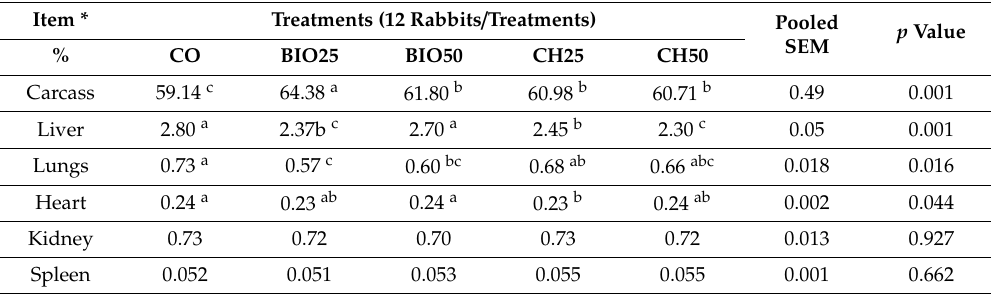
Table 4. Carcass traits of growing New Zealand (NZW) rabbits fed diets supplemented with biological or chemical selenium nanoparticles during heat